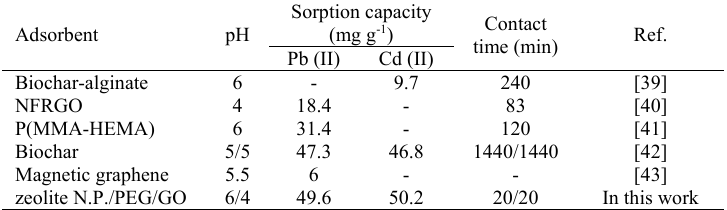
Table 4. Comparison of adsorption capacity (qe) and removal experimental parameters for Pb(II) and Cd(II)